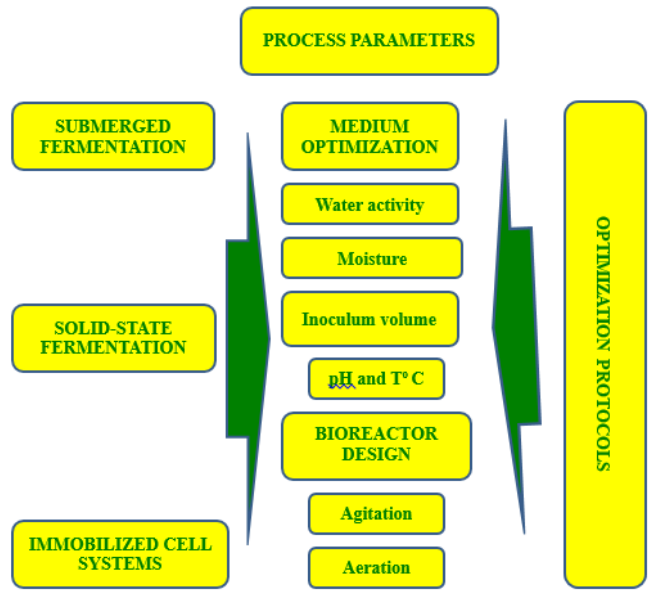
Figure 2. Optimization options for different fermentation profiles.